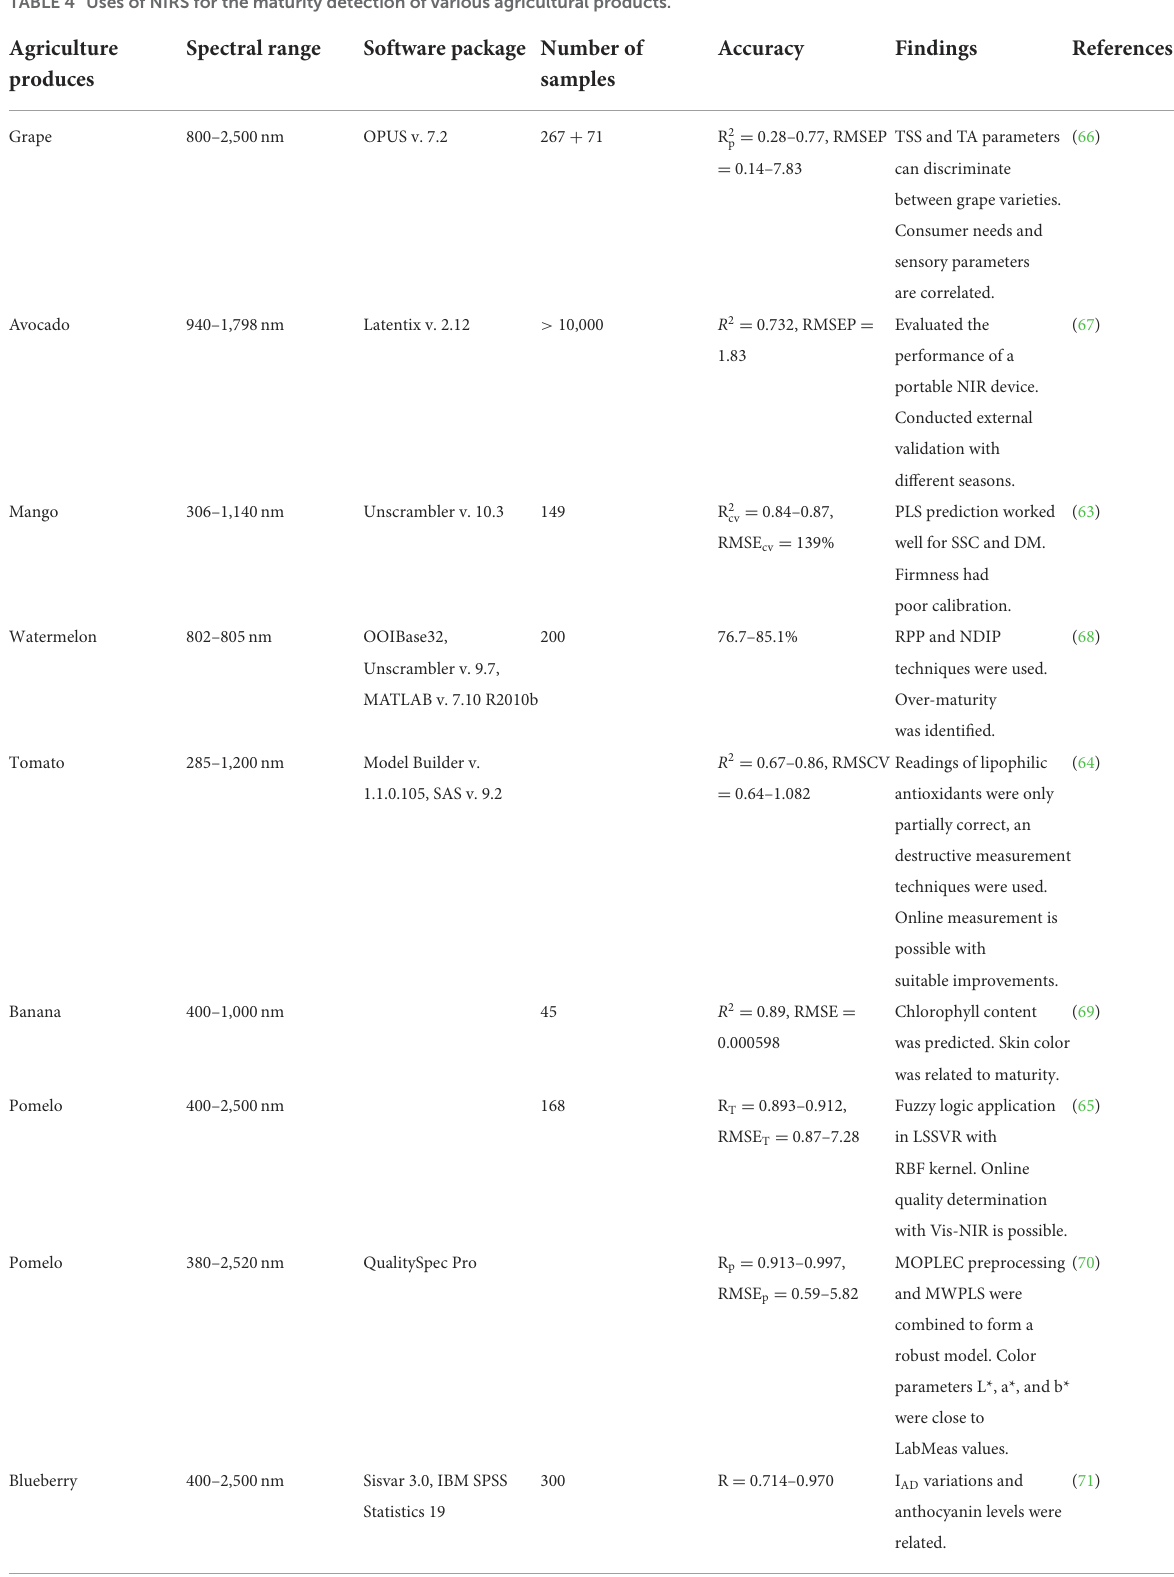
TABLE 4 Uses of NIRS for the maturity detection of various agricultural